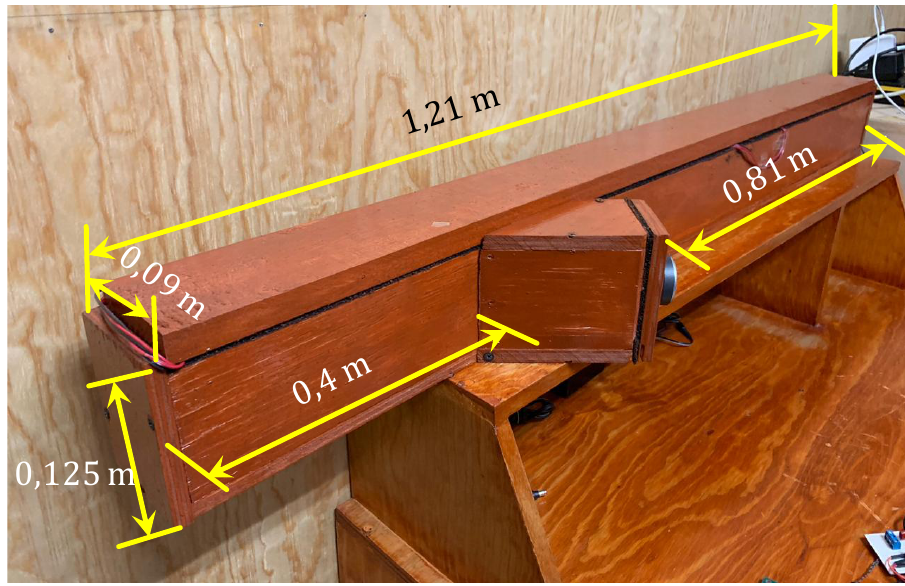
Figure 5. Acoustic duct used in ANC